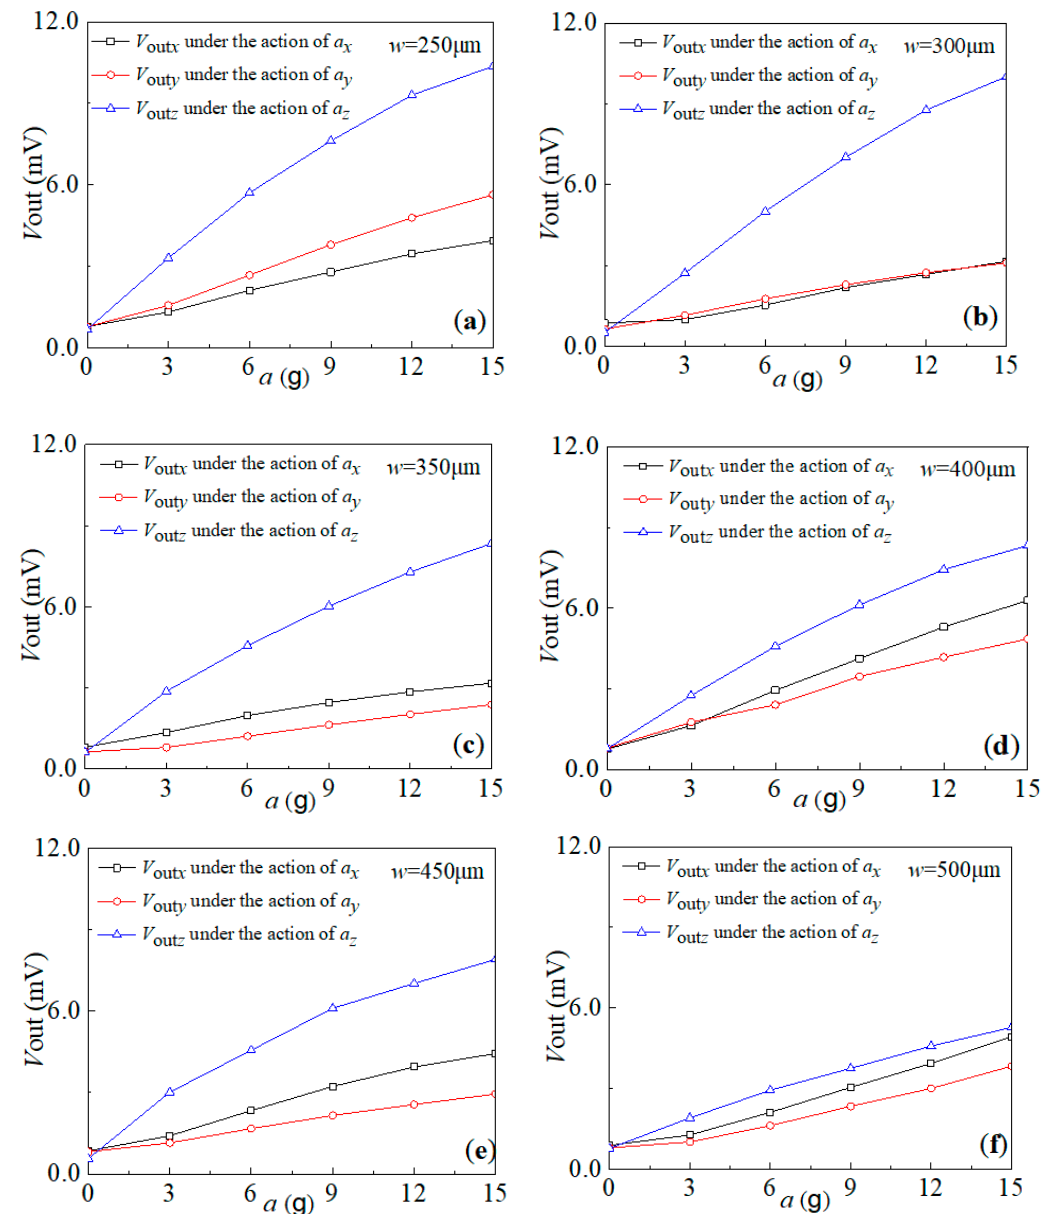
Figure 8. The relationship curves between the output voltages of the proposed sensor and the external acceleration of the six types of sensors with different w values: ( a ) w = 250 μ m; ( b ) w = 300 μ m; ( c ) w = 350 μ m; ( d ) w = 400 μ m; ( e ) w = 450 μ m; and ( f ) w = 500 μ m.